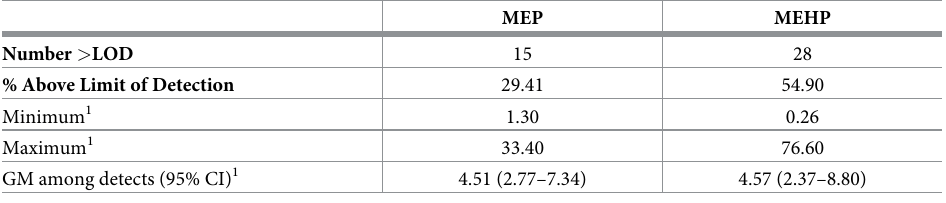
Table 3. Summary of common phthalate metabolites (ng/mL) detected in common bottlenose dolphins sampled during health assessments conducted in Sarasota Bay, FL, USA